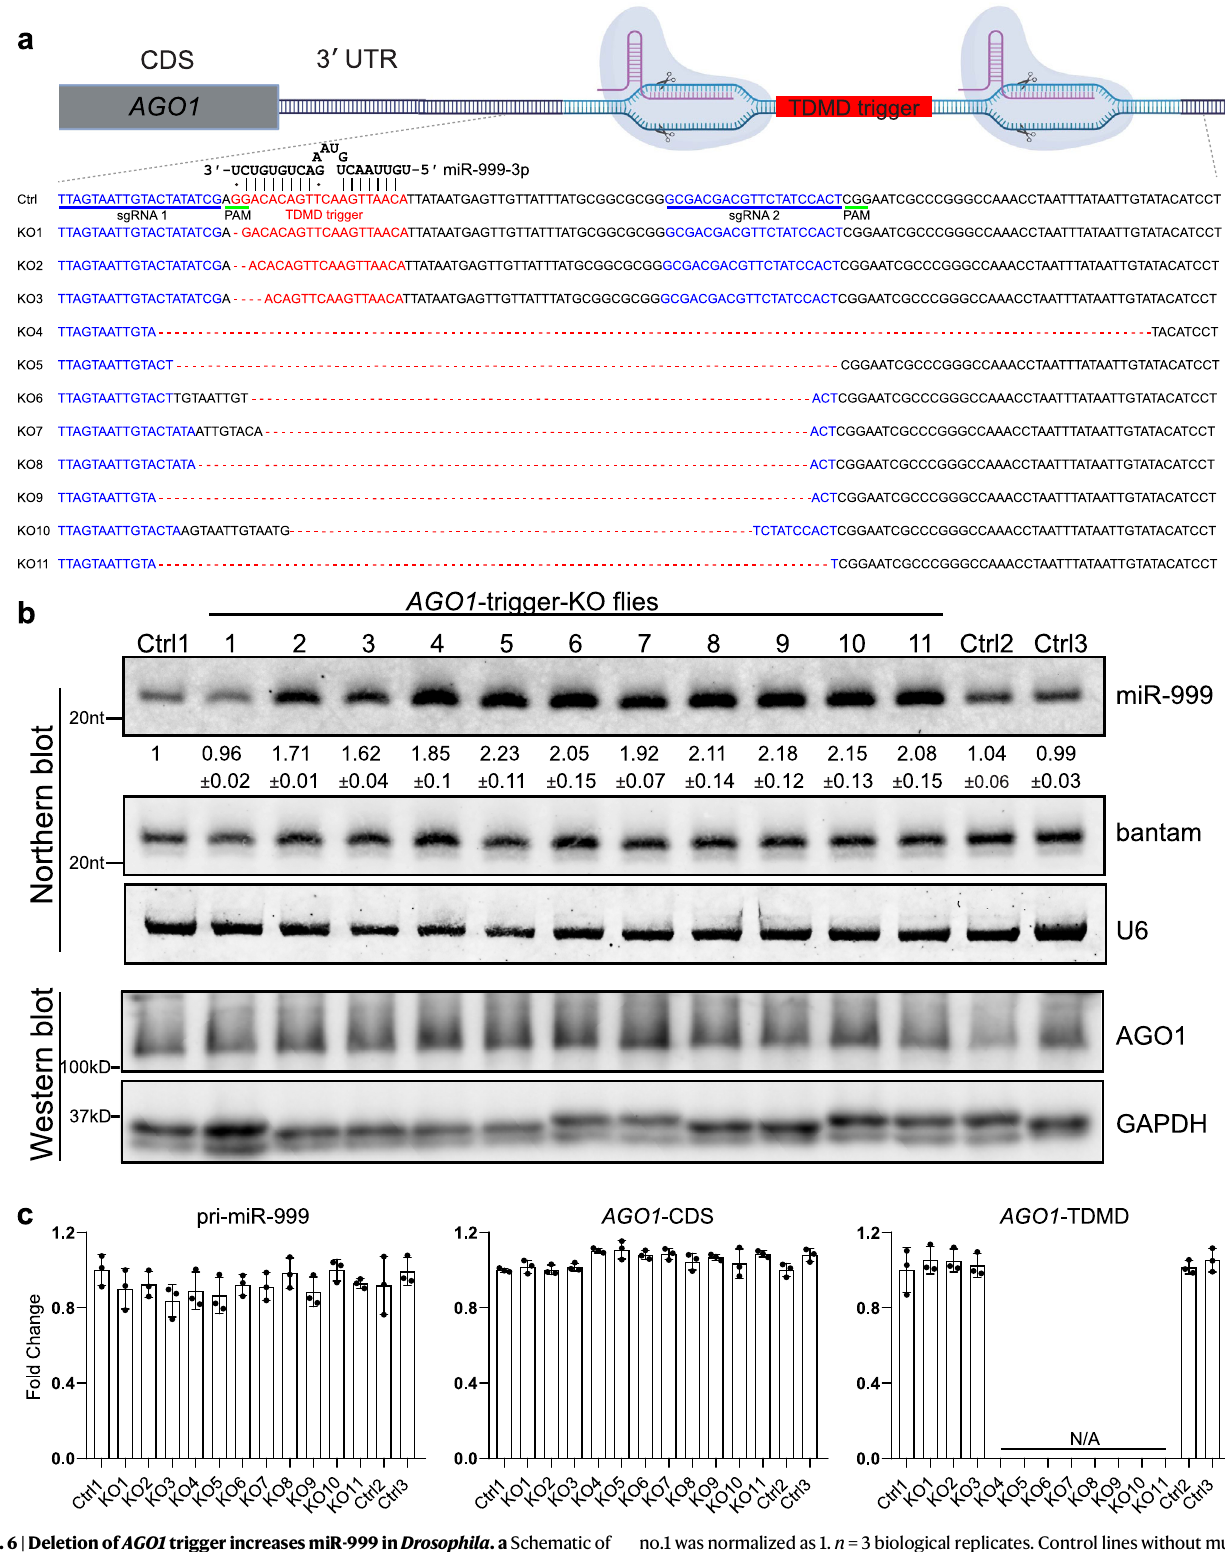
no.1wasnormalizedas1. n =3biologicalreplicates.Controllineswithoutmutation were obtained from same crossing procedure as the mutant lines. Bottom panel: western blot showing AGO1 protein level, with GAPDH as a loading control. c RT- qPCR analyses of pri-miR-999, AGO1 -CDS and AGO1 trigger levels in controls and AGO1 trigger mutant lines as in ( b ), normalized to Actin . Data are presented as mean±SD. n =3 biological replicates. Source data are provided as a Source Data fi